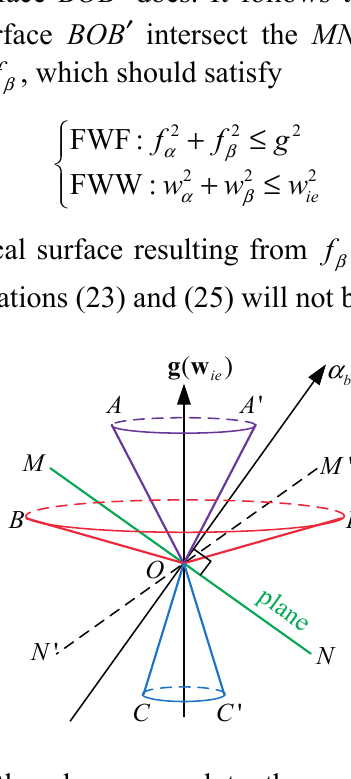
Figure 6. Intersection with the plane normal to the